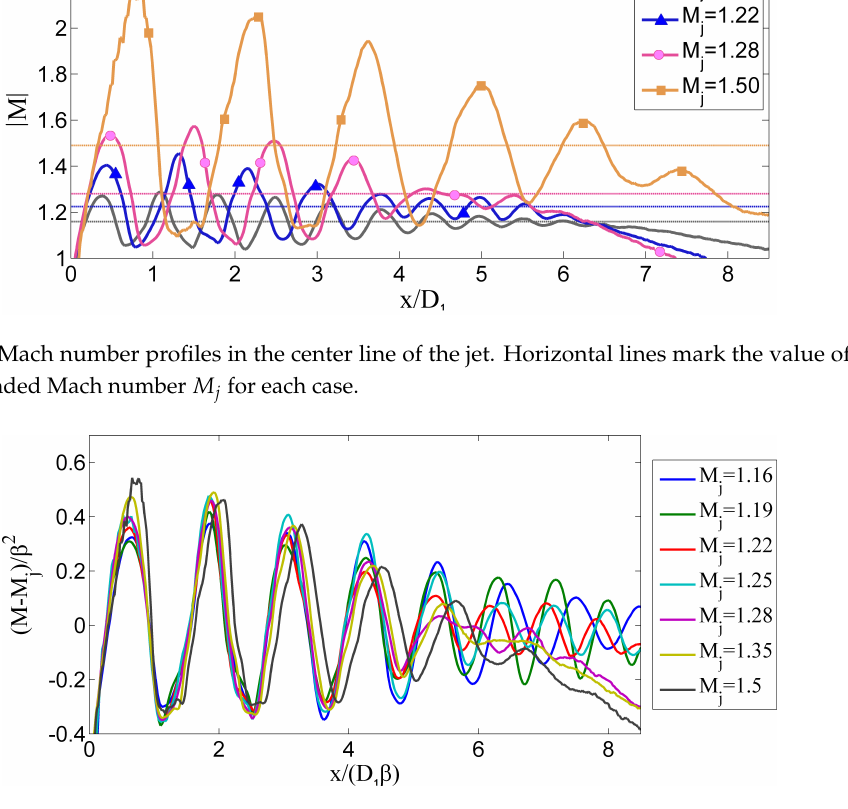
Figure 19. Normalization of the Mach number profiles in the center line of the jet proposed by Savarese